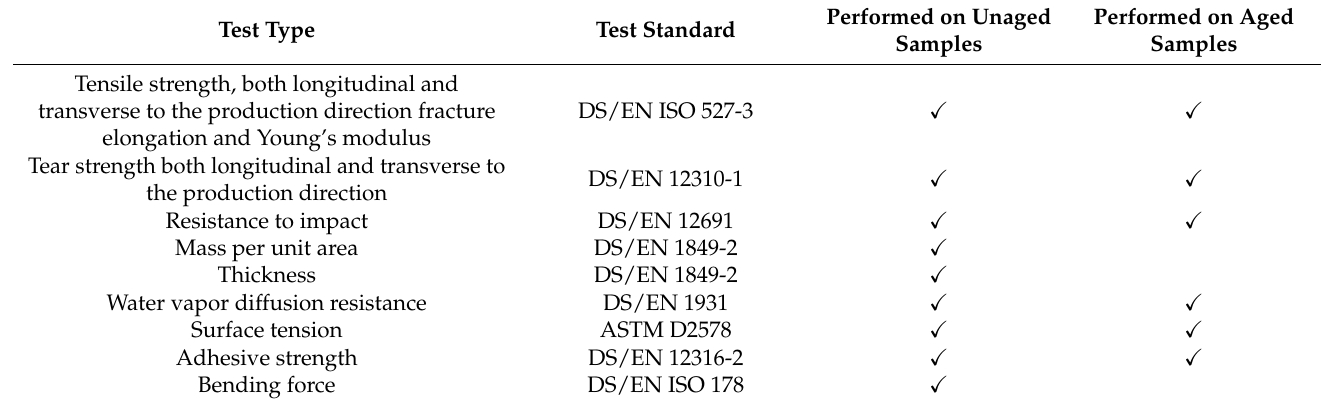
Table 3. Physicomechanical tests performed on membranes.